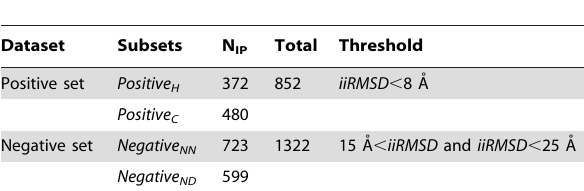
Table 1. Positive and negative